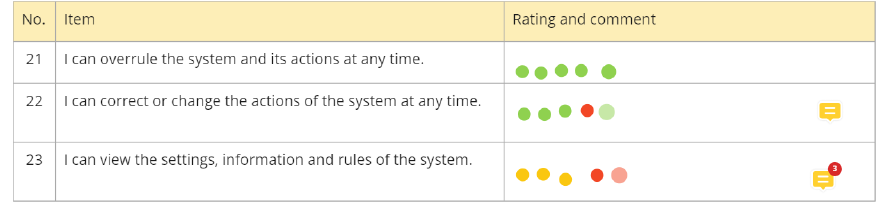
Figure 5. Exemplary items illustrating the process of rating the items during the virtually conducted expert workshop to revise the item pool with color coded decisions and comments. expert workshop to revise the item pool with color coded decisions and